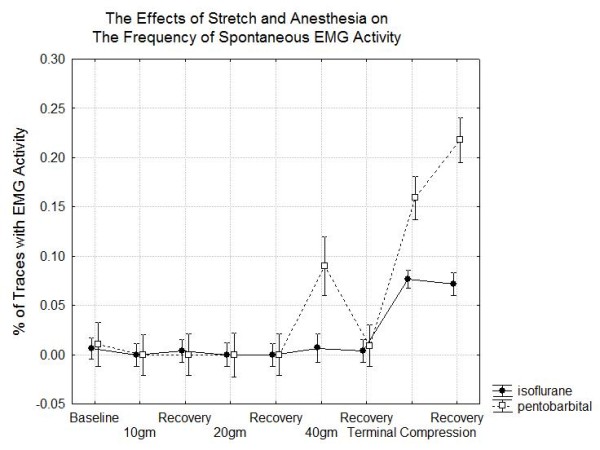
Changes in spontaneous electromyographic (EMG) activity during the experiment.